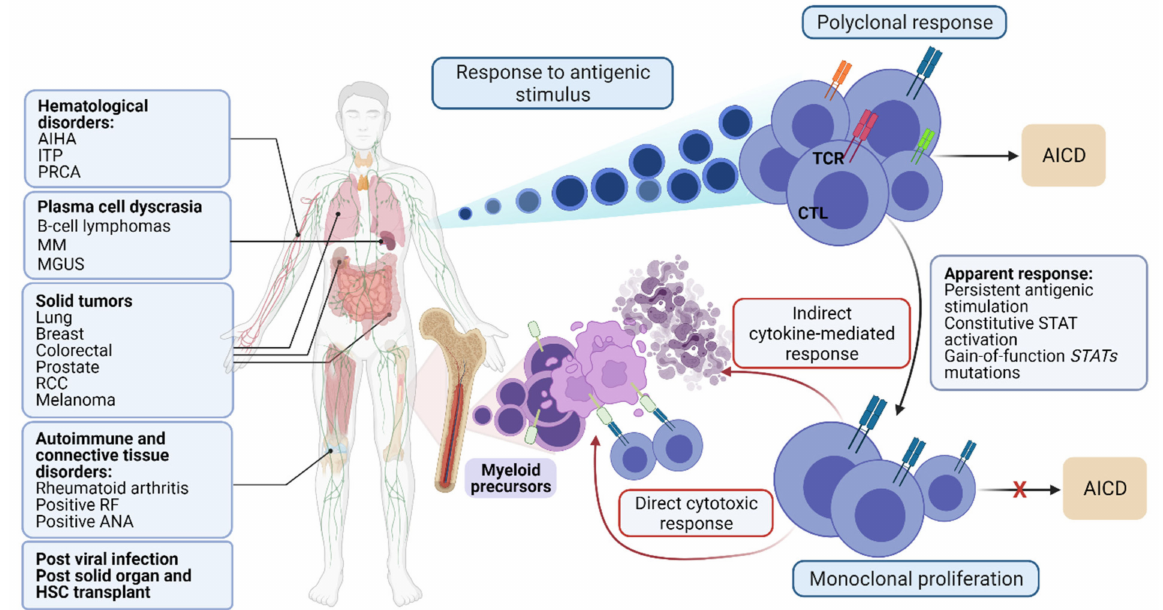
Figure 1. Diseases commonly associated with LGLL and schematic representation of underlying pathogenesis. MGUS: Monoclonal gammopathy of undetermined significance; PRCA: pure red cell aplasia; AIHA: autoimmune hemolytic anemia; MDS: Myelodysplastic syndrome; HSC: hematopoietic stem cell. AICD: activation-induced cell death; STAT: Signal Transducer and Activator of Transcription 3; TCR: T-cell receptor; CTL: cytotoxic T-cells; ITP: Immune thrombocytopenic purpura; MM: multiple myeloma; RCC: Renal cell carcinoma; RF: rheumatoid factor; ANA: antinuclear antibodies. Figures were generated with BioRender.com (accessed on 20 August